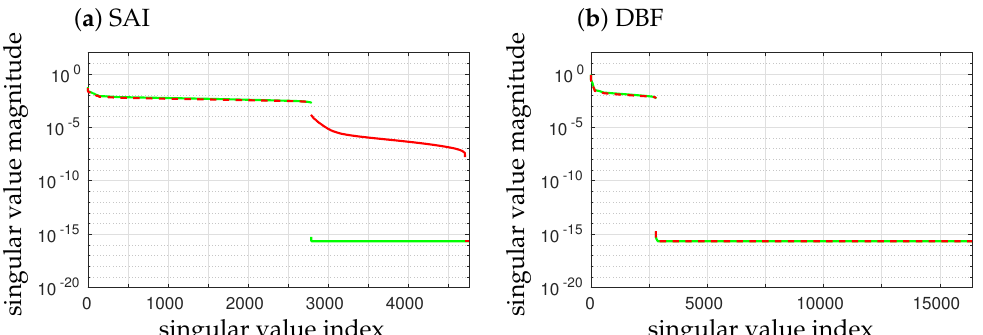
Figure 4. Distributions of the singular values of the modeling matrices G in X polarization for ( a ) the SAI paradigm and for ( b ) the DBF one. Whatever the approach, two groups of singular values separated by a well-determined gap are observed. In every case, the first group is composed of the 2791 largest singular values. However, in the SMOS case (red, 69 different antenna patterns), this gap is narrower than in the ideal case (green, same voltage pattern for each antenna), except for the DBF, which is less sensitive to the disparity of the elementary patterns. The same behavior is observed in Y